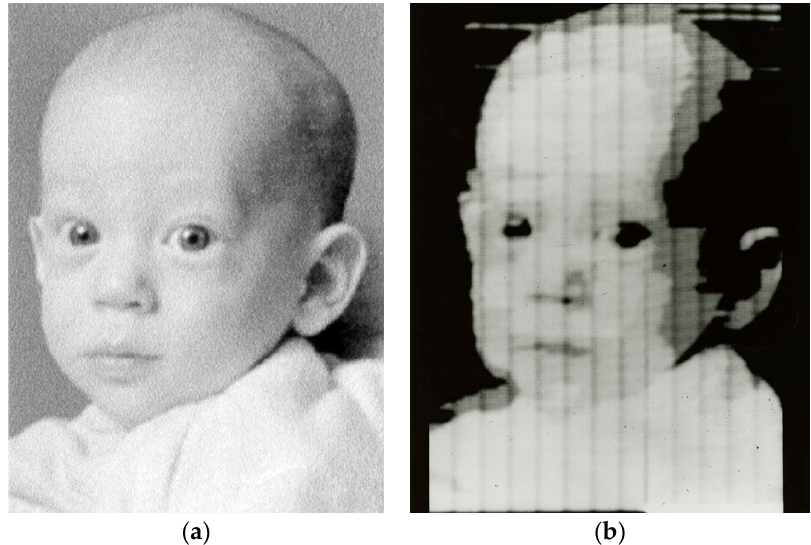
Figure 2. The photograph of Walden Kirsch: ( a ) The original one; ( b ) The image after the scanning process.